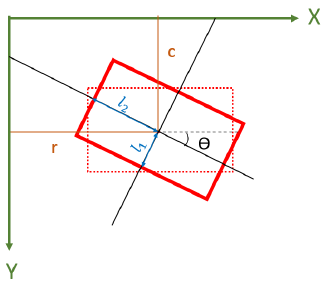
Figure 1. The architecture of the proposed method.